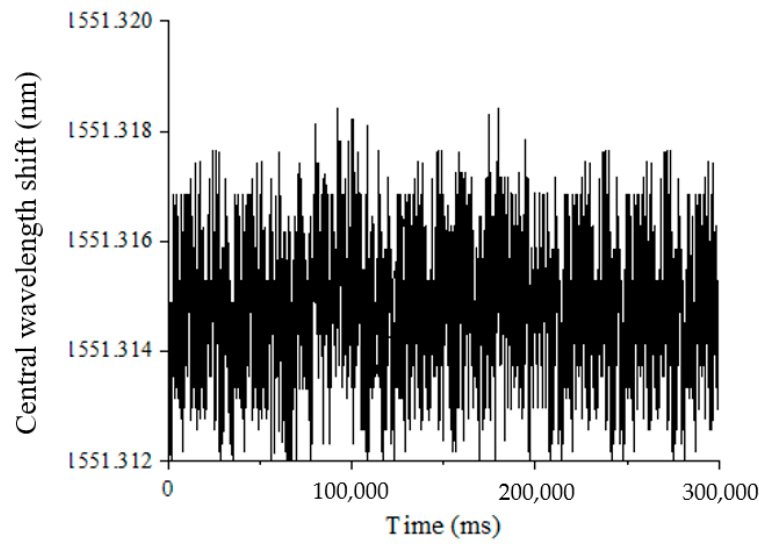
Figure 14. Central wavelength variation of #3FBG caused by temperature.